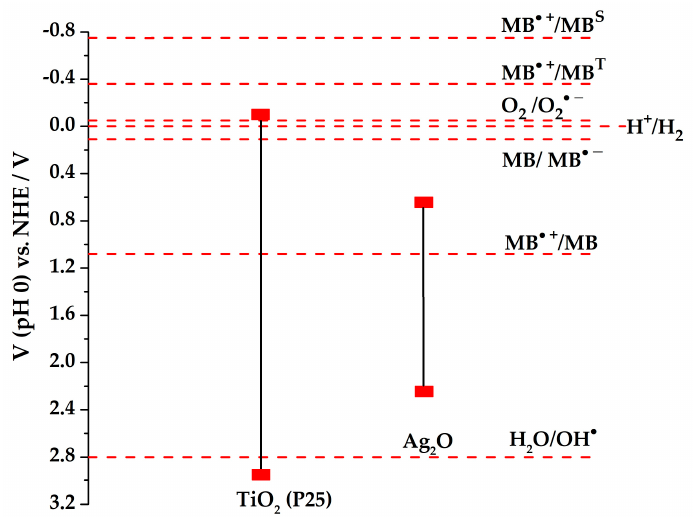
Figure 6. The electrochemical potentials (vs. NHE) of the valence and conduction bands of TiO 2 and Ag 2 O, and the reduction potentials of some species (possibly) present in the surrounding electrolyte. MB, MB •− , MB • + , MB T , and MB S denote the MB ground state, the semi-reduced MB, the oxidized MB, the excited triplet state, and the excited singlet state of MB, respectively. The one electron reduction potentials have been calculated with data given in References [44,47,48].